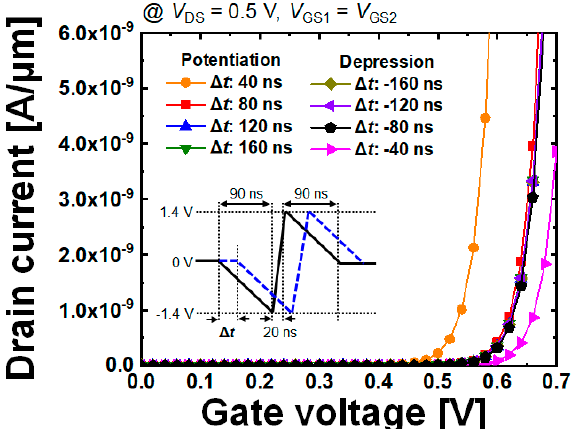
Figure 9. Simulated spike-timing-dependent plasticity (STDP) characteristics of the SFGST after a single triangular spike. Following the Hebbian learning rule [16], the synaptic change is determined by ∆ t .